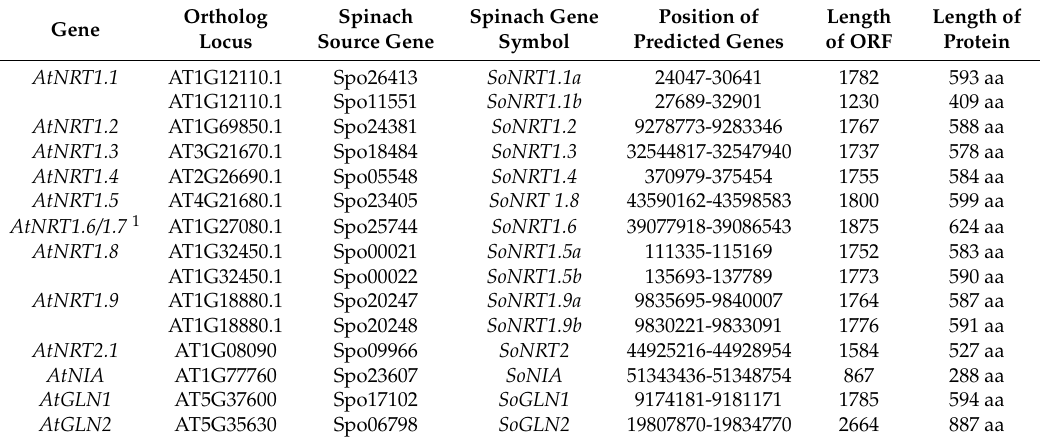
Table 3. Genes involved in nitrate transport and assimilation identified in spinach.